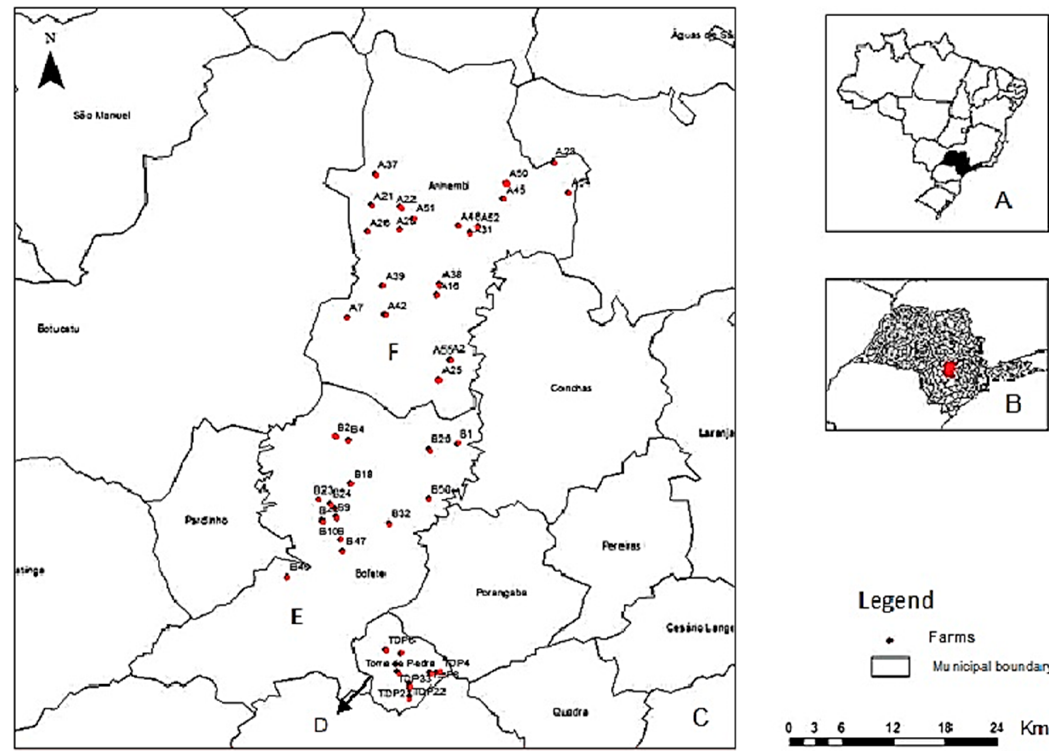
Figure 1. Map of the sampling sites in Brazil ( A ) with São Paulo State shown in black. São Paulo state map ( B ) with Torre de Pedra, Bofete, and Anhembi in red. Map of São Paulo State ( C ) showing the sampling sites; the points in red correspond to the farms in Torre de Pedra ( D ); Bofete ( E ), and Anhembi ( F ). Source: Peres et al., 2013 [14].